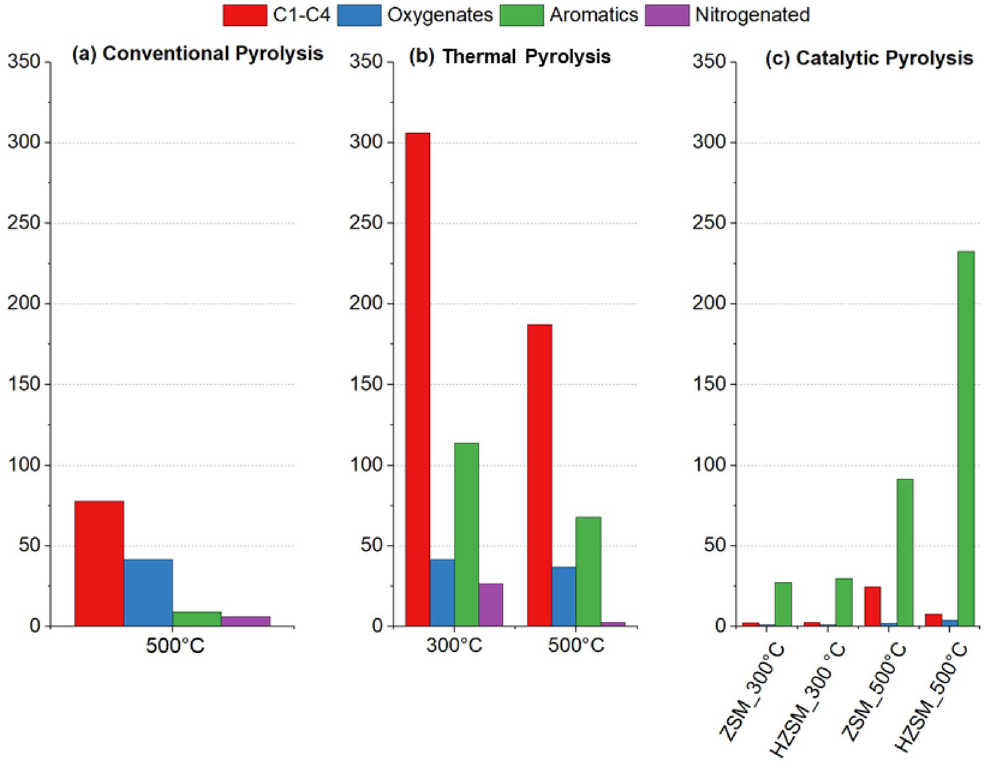
Figure 5. Pyrolysis products by